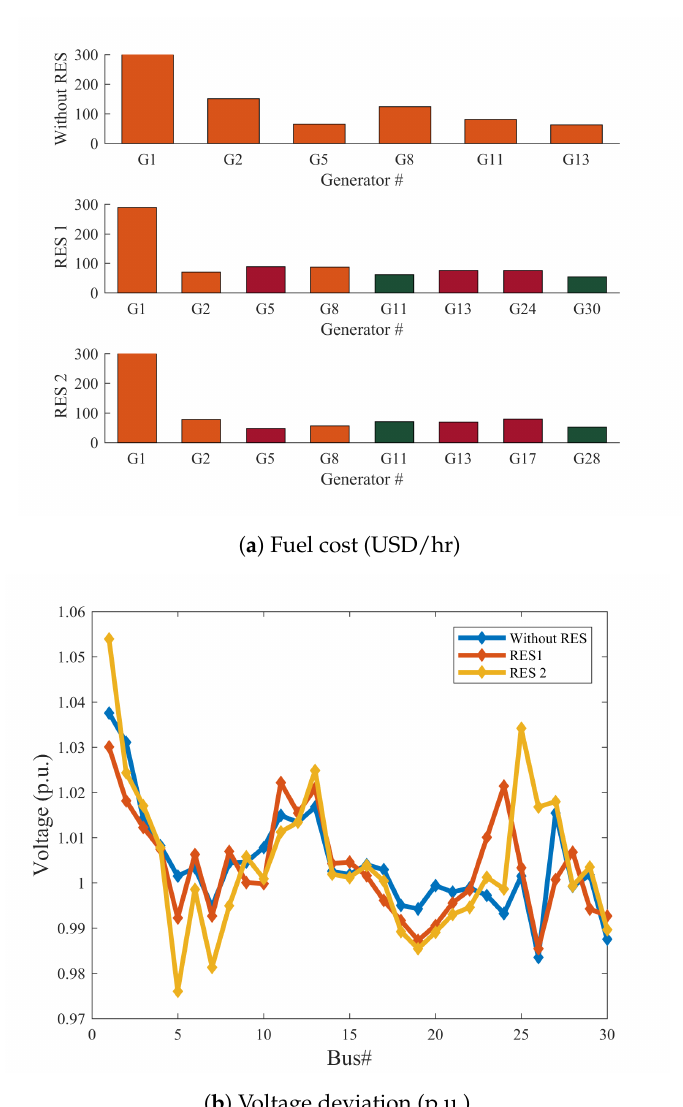
Figure 13. Fuel cost and Voltage deviation for case 8 for IEEE 30-bus system, IEEE 30-bus Modified (1) and IEEE 30-bus Modified